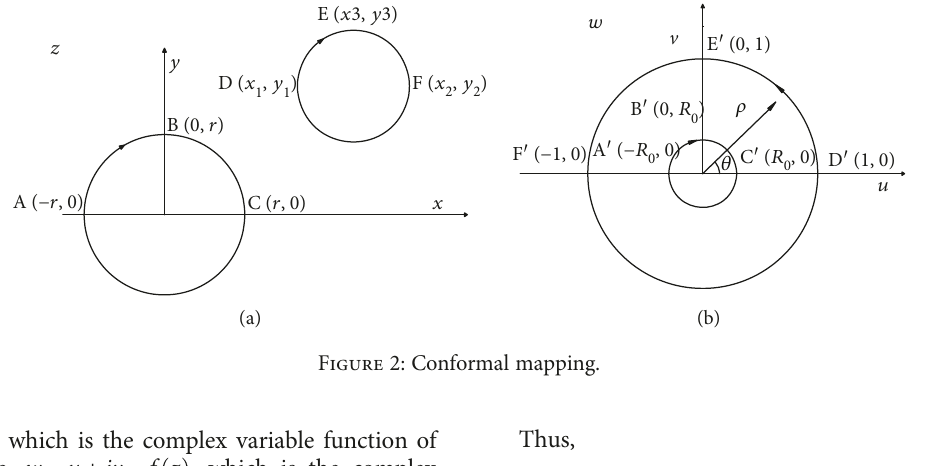
Figure 2: Conformal